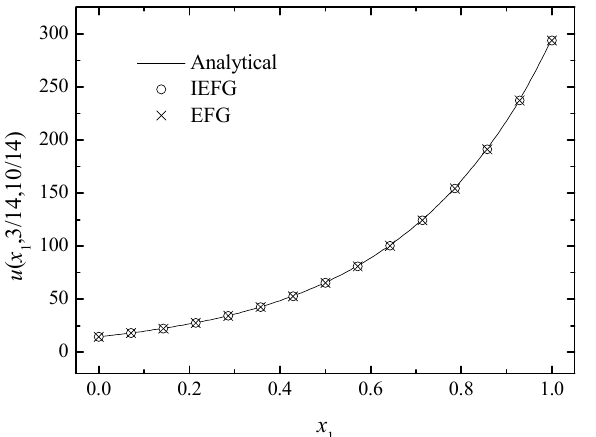
Figure 10. The comparison of the numerical and analytical solutions of the two methods along the x 1 -axis.